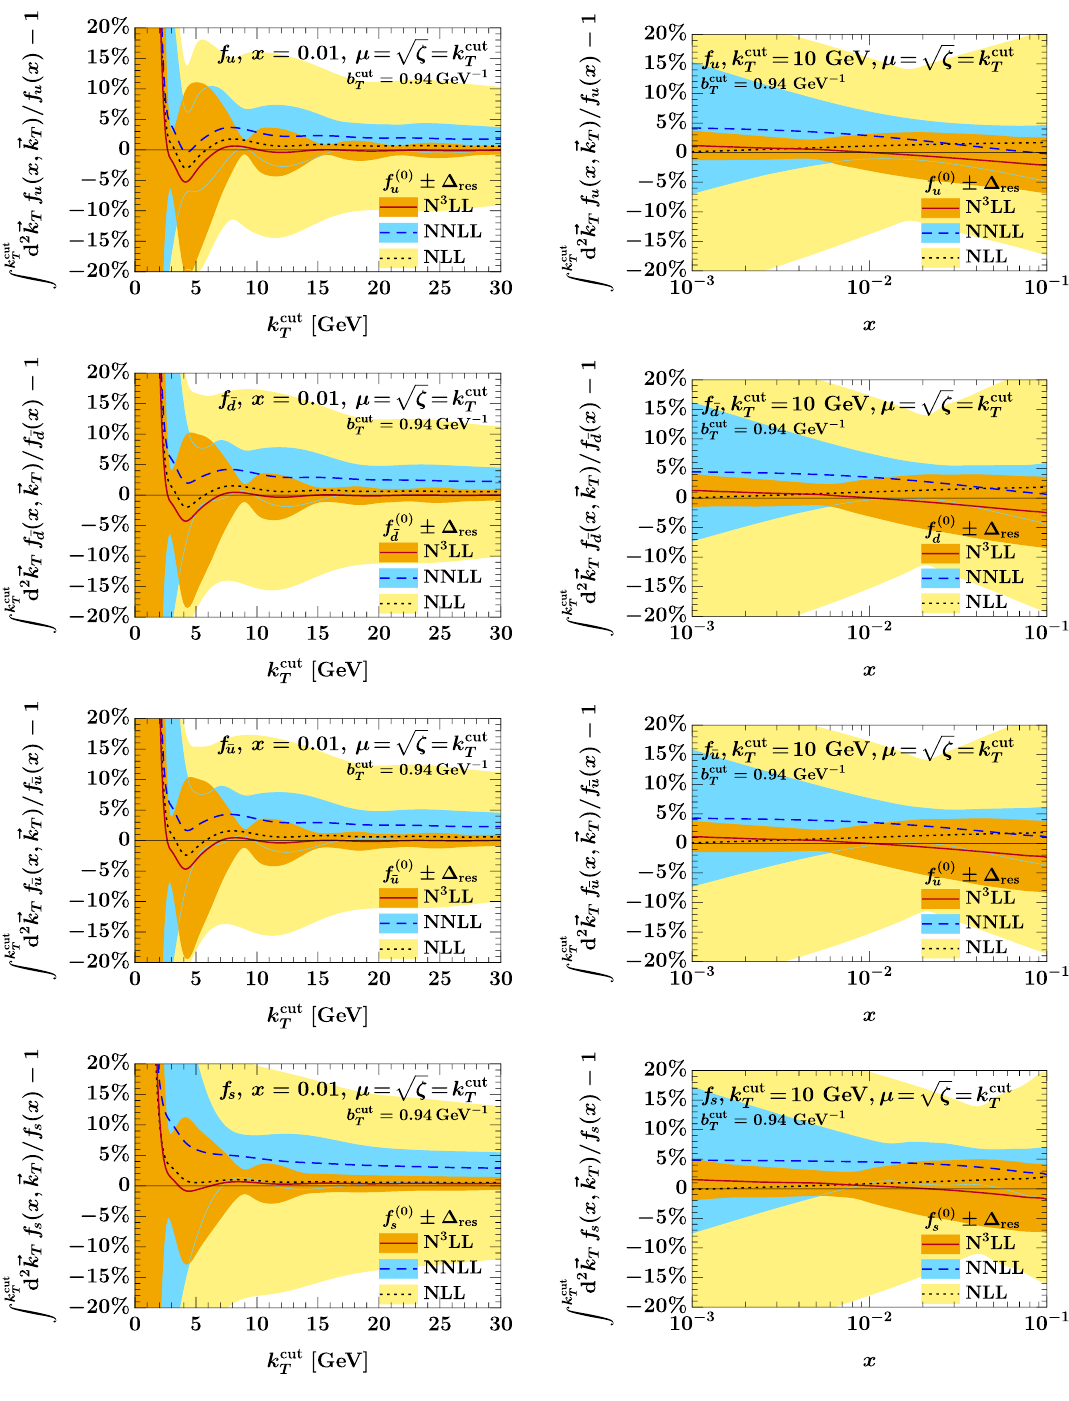
Figure 13 . Same as figure 7, for i = u, ¯ d, ¯ u, s